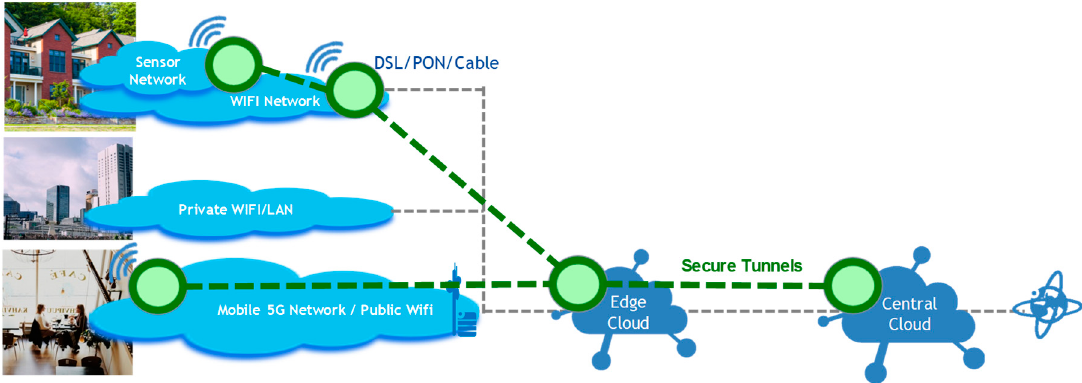
Figure 4. Distributed Future Spaces cloud architecture.